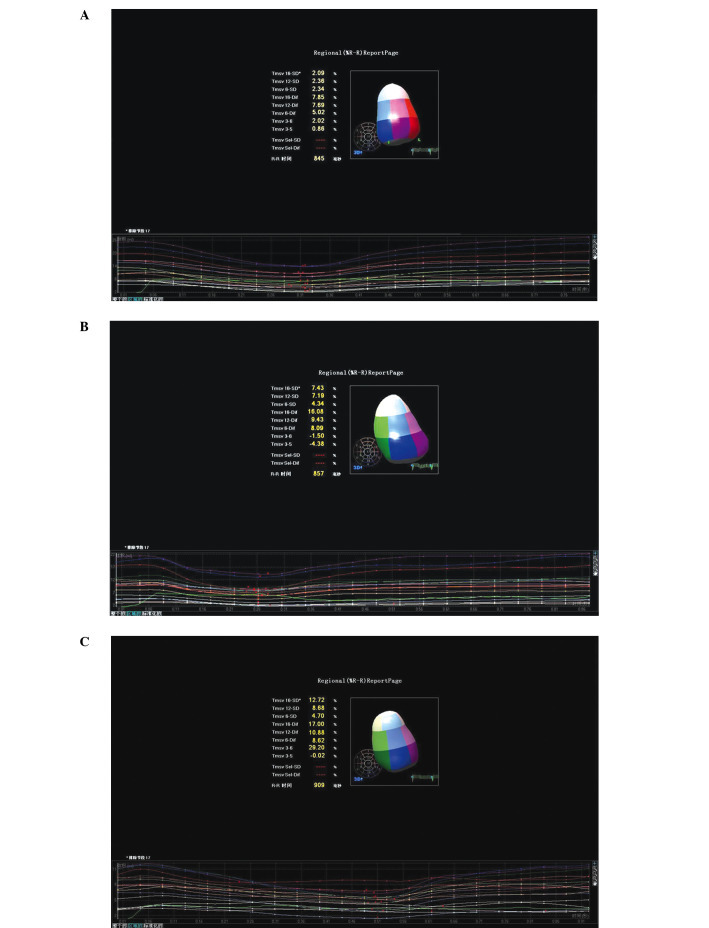
Real-time three-dimensional echocardiography (RT3DE) 17 regional left venrticular (LV) volume-time curves (VTCs) for one patient. (A) VTCs in one patient from the AAI pacing mode. The Tmsv16-SD% and Tmsv16-Dif% of LV dyssynchrony indices were 2.09 and 7.85%, respectively. (B) VTCs in the same patient from the DDD pacing mode. The Tmsv16-SD% and Tmsv16-Dif% of LV dyssynchrony indices were 7.43 and 16.08%, respectively. (C) VTCs in the same patient from the VVI pacing mode. The Tmsv16-SD% and Tmsv16-Dif% of LV dyssynchrony indices were 12.72 and 17.0%, respectively.